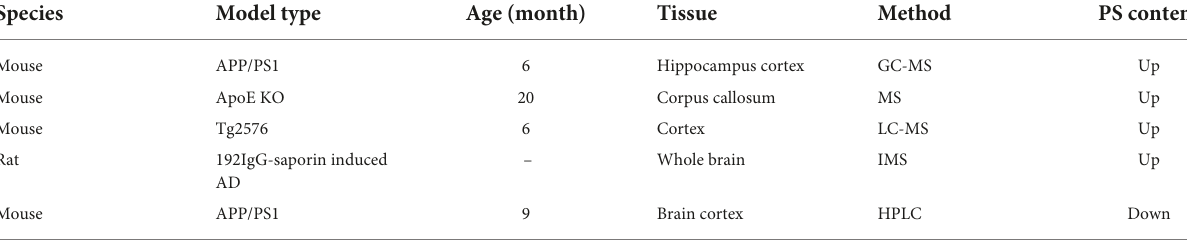
TABLE 3 The alteration of phosphatidylserine (PS) in Alzheimer’s disease (AD)